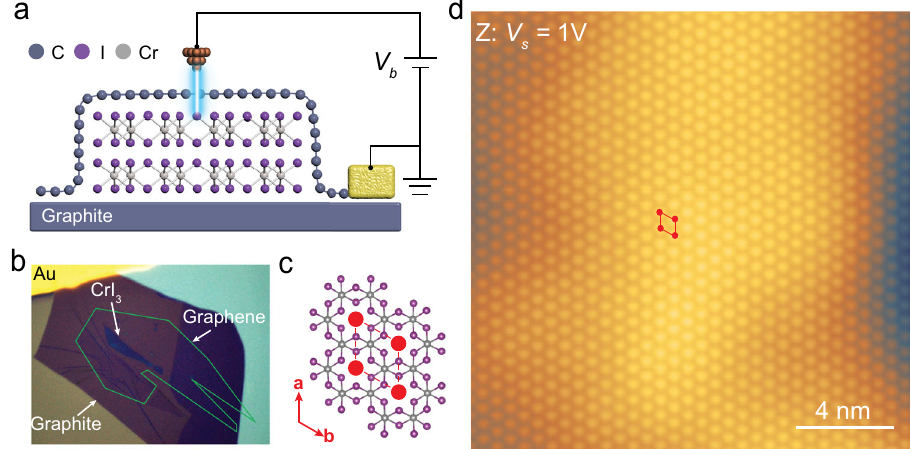
Fig. 1 The vdW heterostructure of G/FL-CrI 3 /Gr for STM study. a The schematic illustration and b the optical image of our experimental setup. Our sample consists of monolayer graphene covering FL-CrI 3 stacking on graphite fl ake (G/FL-CrI 3 /Gr). c The atomic structure of monolayer CrI 3 (top view). d Large-size STM topographic image of G/FL-CrI 3 /Gr ( V s = 1 V, I t = 0.1